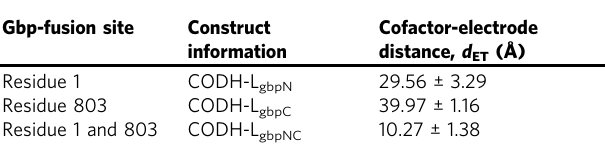
Table 1 Estimated distances between the electrode surfaces and the Mo – Cu cofactor, d ET